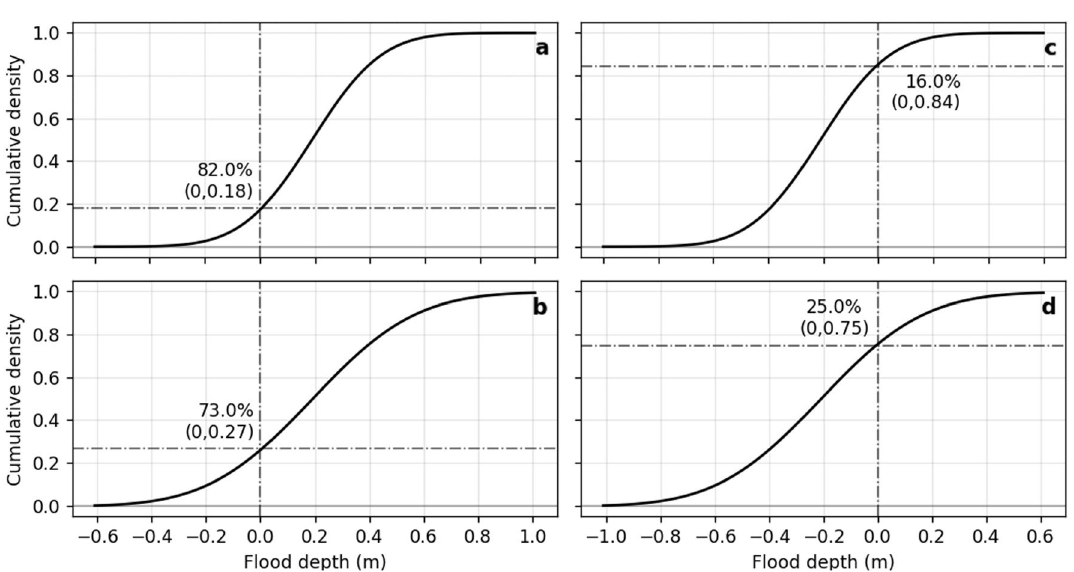
Figure 7. Comparison of two pairs of CDFs with the same mean but different flood-depth spread. CDF pair 8a and 8b illustrate differences that would result in an at least 80% probability-based map. CDF pair 8c and 8d show the result of a probability-based map of at least 20%. The figure illustrates how the shape of the CDF affects probability for a given flood